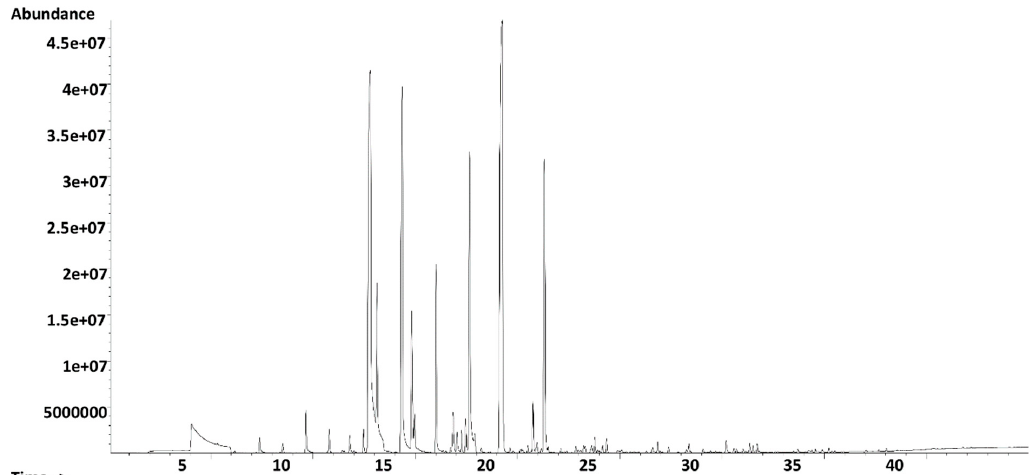
Figure 1. An exemplary total ion chromatogram of a volatile fraction of pasteurized apple juice obtained by the headspace solid-phase microextraction-gas chromatography-mass spectrometry (HS-SPME-GC-MS) fingerprinting method.